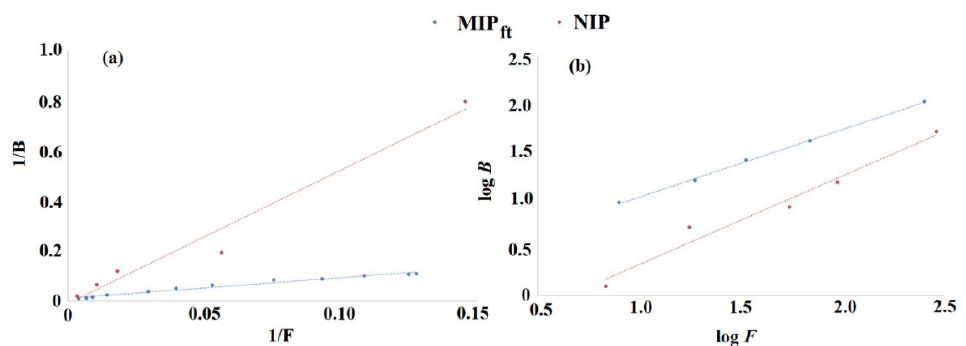
Figure 2. Lineweaver–Burk ( a ) and Freundlich ( b ) models for tyramine adsorption on MIP ft and